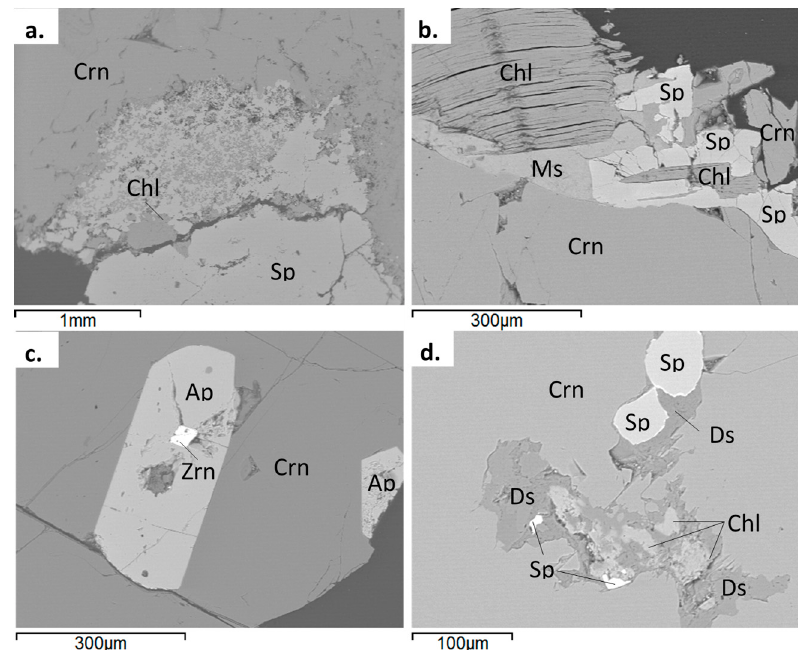
Figure 4. Backscattered (BSE) images of corundum ‐ spinel ‐ chlorite samples from the central zone: ( a ) Corundum ‐ spinel intergrowth with inclusions of clinochlore; ( b ) The rim of corundum ‐ spinel concentric aggregate with intergrowth of clinochlore and muscovite; ( c ) Inclusions of apatite and zircon within corundum; and, ( d ) Inclusions of spinel, clinochlore, and diaspore (Ds) within corundum. Mineral abbreviations are after [12]. BSE images by E.S. Sorokina.